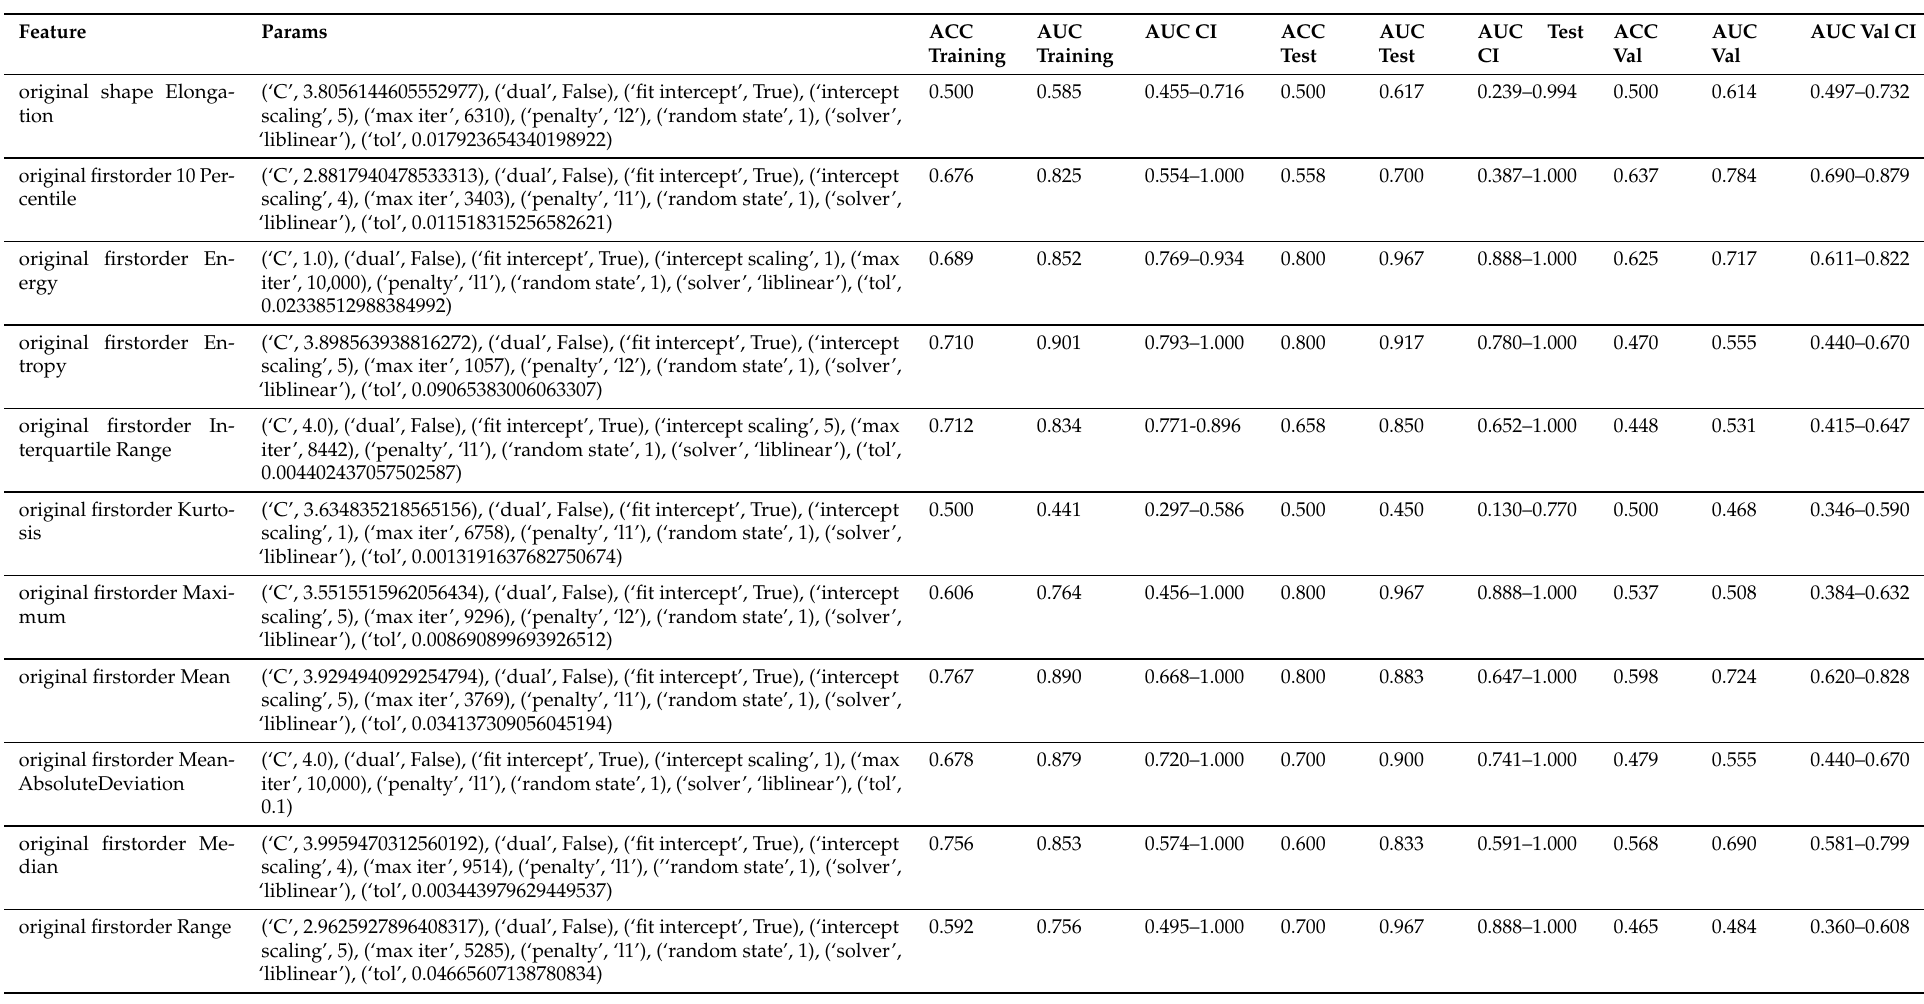
Table A2. ML Parameters and Diagnostic Performance of Individual SUV metrics and Radiomic Features : Key— ML (Machine Learning) , ACC (Accuracy) , CI (Confidence Interval) , AUC (Area Under the Receiver Operating Characteristic Curve) , Val (Validation) , SUV (Standardized Uptake Value) , GLDM ( Gray-Level